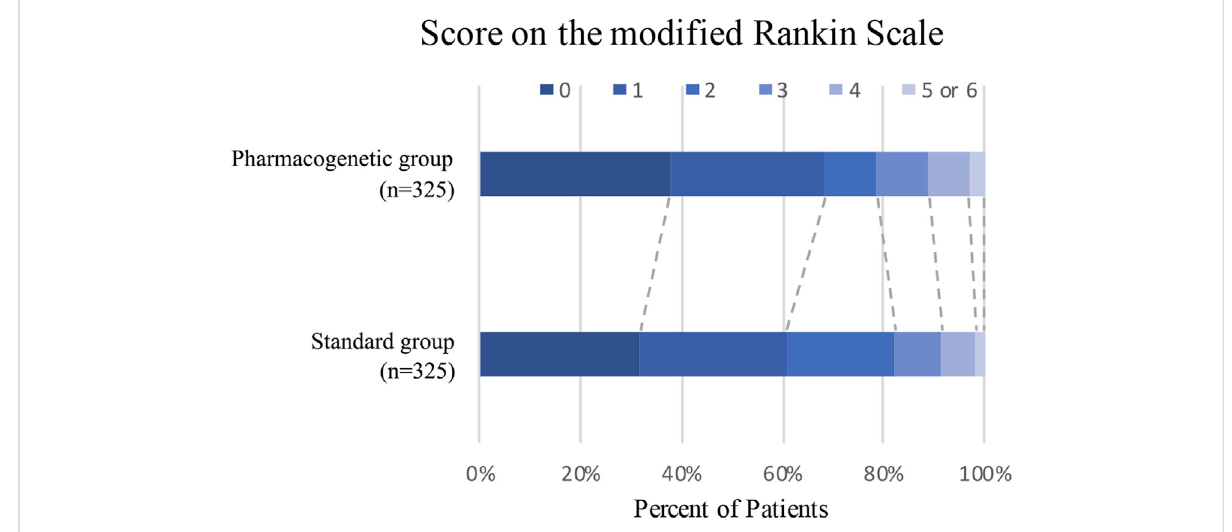
FIGURE 3 Distribution of modi fi ed Rankin Scale scores at 90 days. Distribution of scores for disability on the modi fi ed Rankin Scale among patients in the pharmacogenetic or standard group is shown. Scores vary from 0 to 6, with higher scores indicating more severe